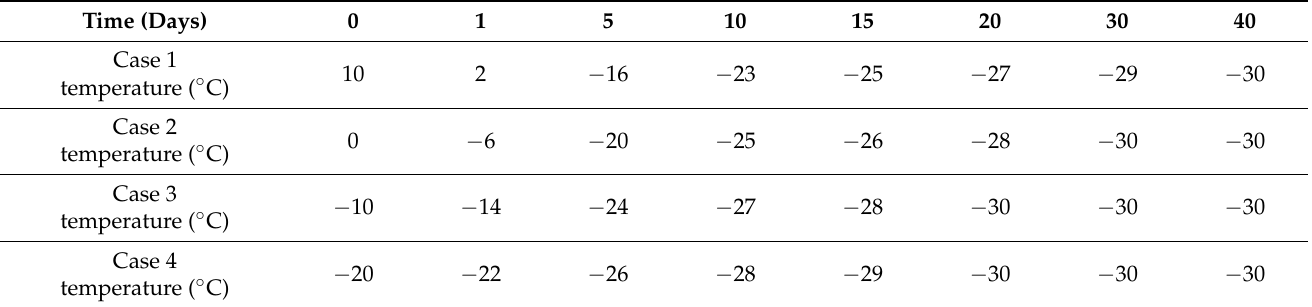
Table 4. Cooling schedule for different initial temperatures.